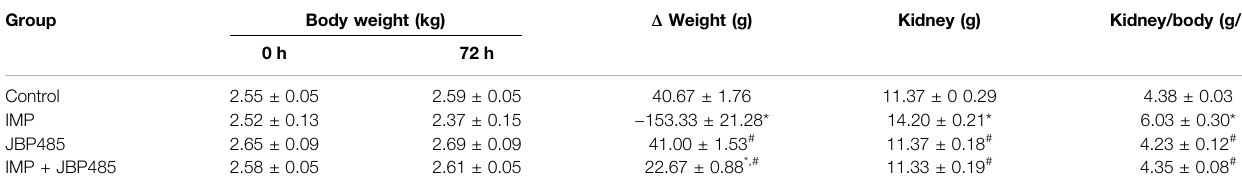
TABLE 1 | Effects of JBP485 on IMP-induced changes in body and kidney weights of rabbits. Group